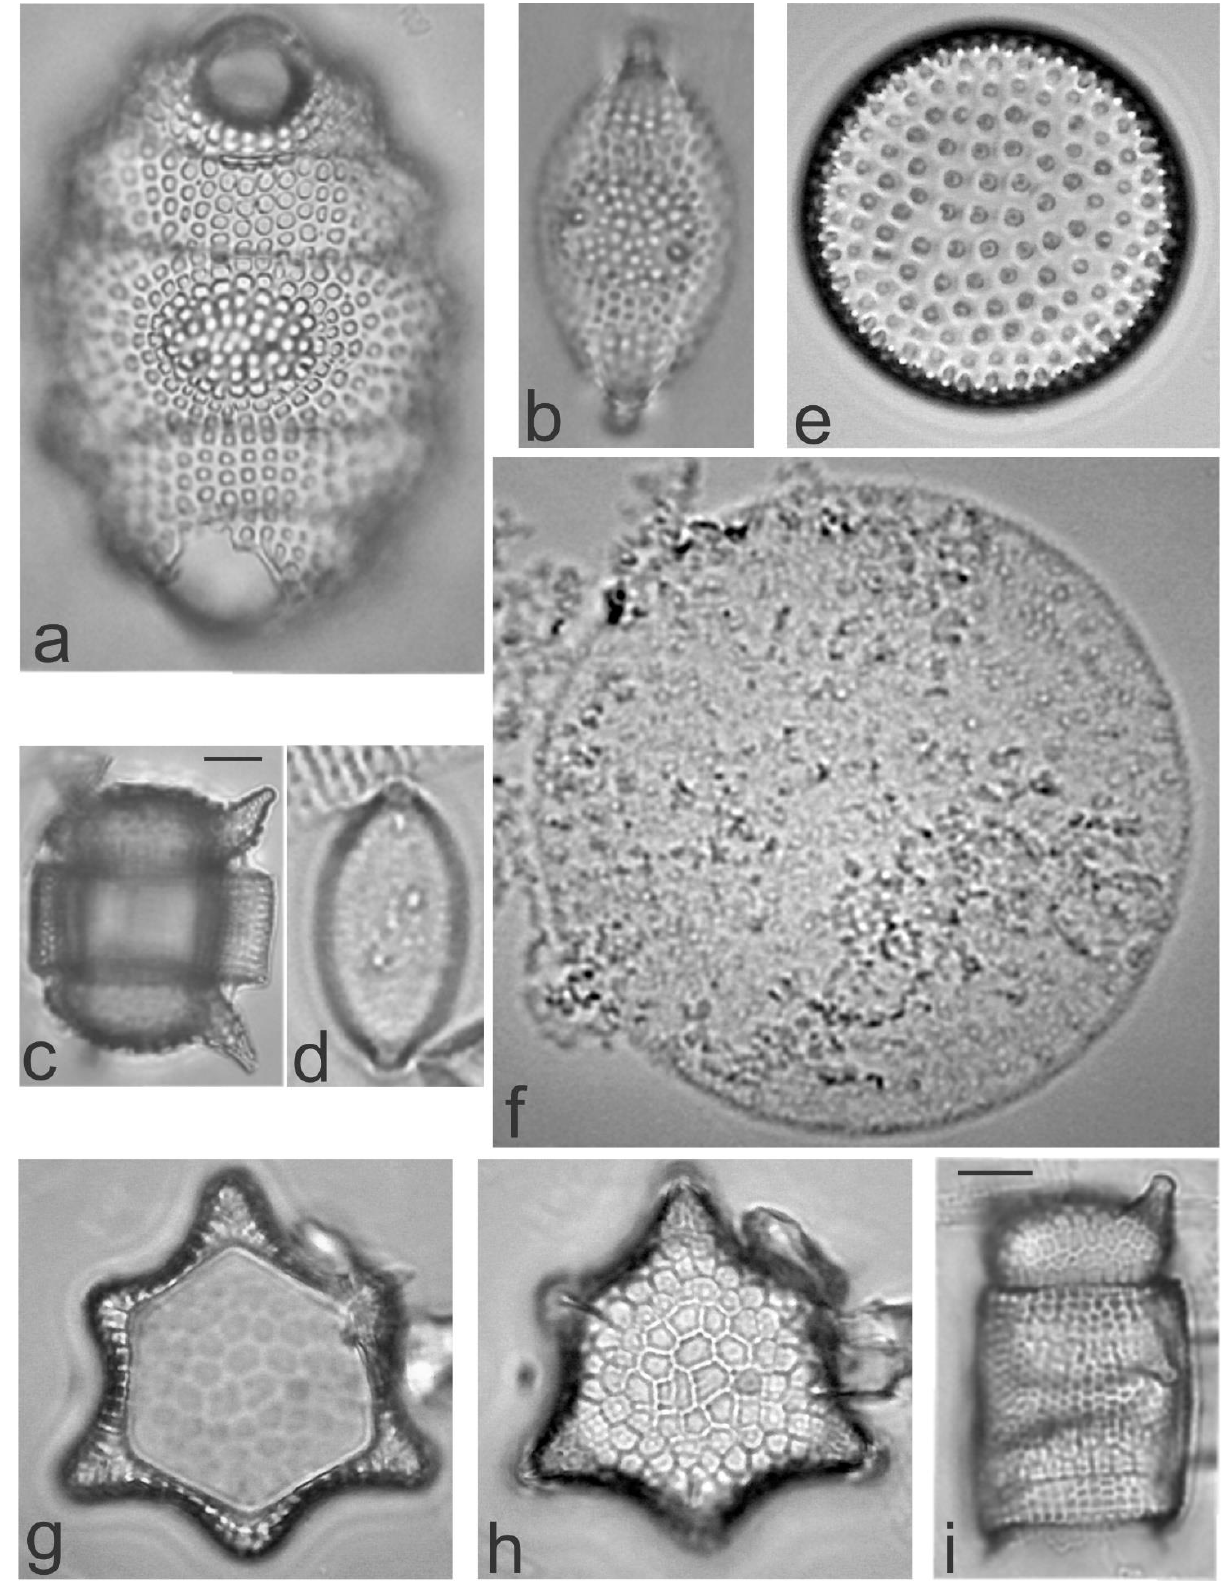
Figure 3. ( a ) Biddulphia biddulphiana ; ( b , c ) Odontella aurita ; ( d ) Biddulphia subaequa ; ( e ) Psammodiscus nitidus ; ( f ) Coscinodiscus sp. 1; ( g – i ) Pseudodictyota dubia . Scale bars: ( b – d , e – i ) = 10 μm; ( a ) = 15 μm.